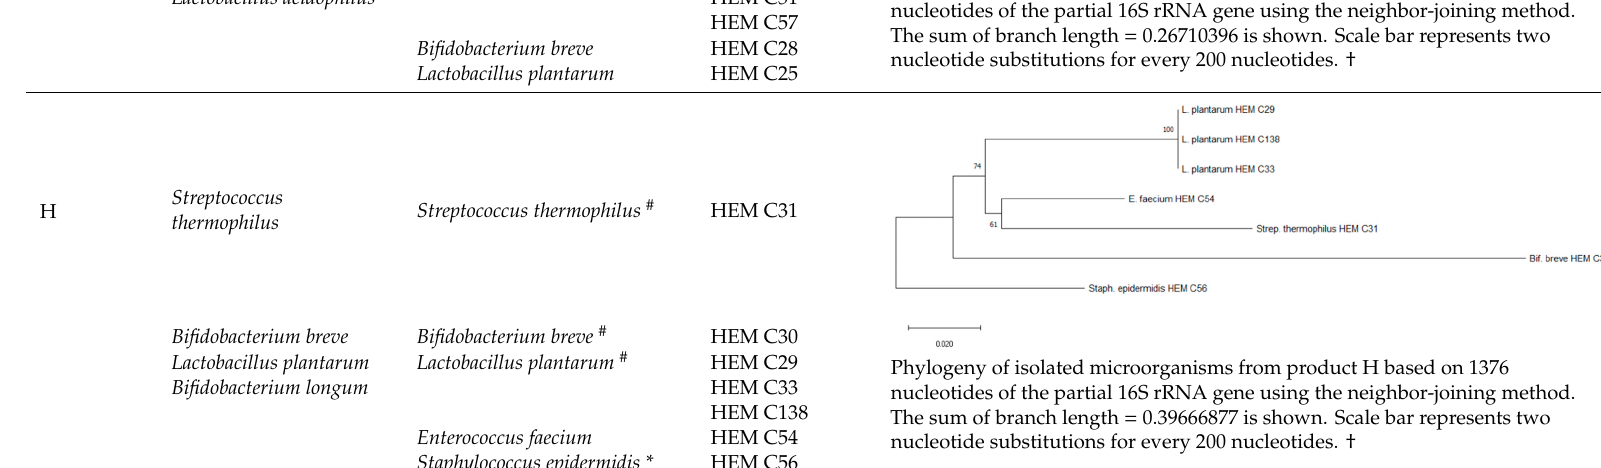
Phylogeny of isolated microorganisms from product H based on 1376 nucleotides of the partial 16S rRNA gene using the neighbor-joining method. The sum of branch length = 0.39666877 is shown. Scale bar represents two nucleotide substitutions for every 200 nucleotides. †